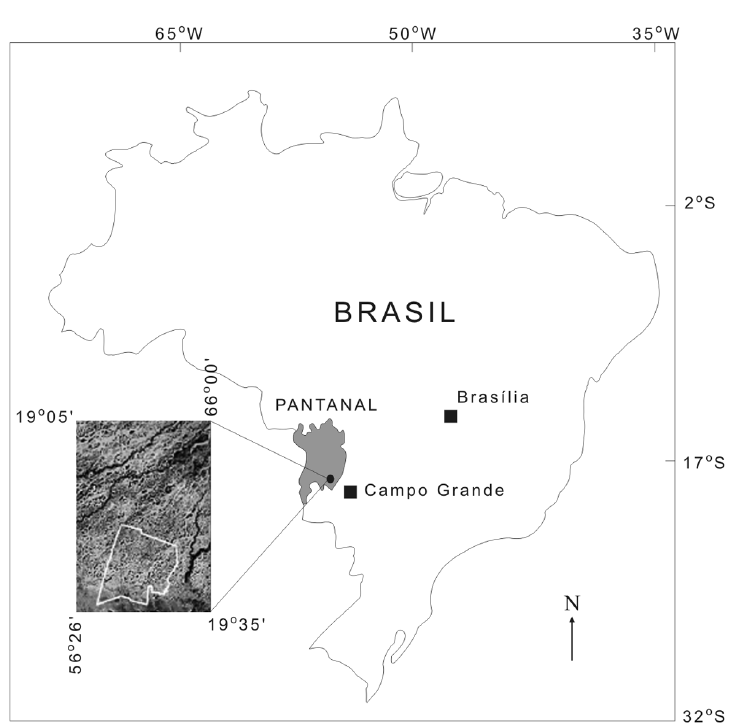
Fig. 1 – Localisation of Pantanal and the studied area (modified from Galvão et al.